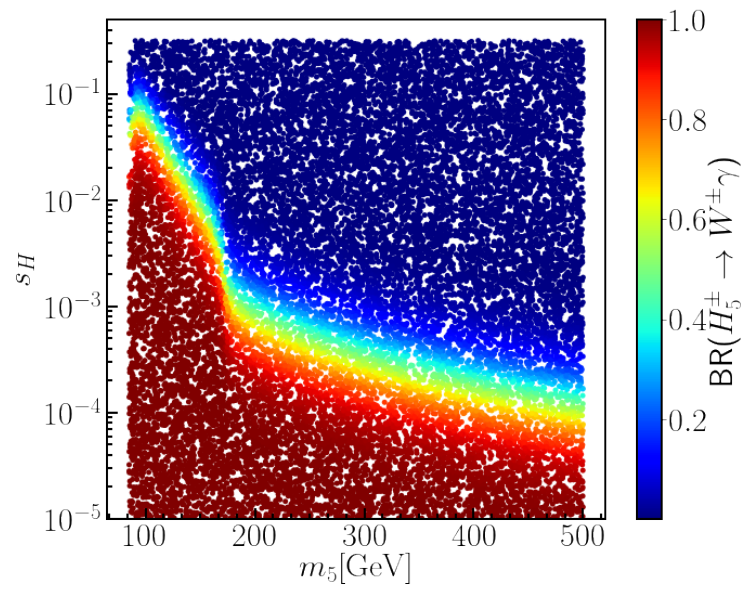
Figure 3 . Dependence of BR( H (cid:6) W (cid:6) (cid:13) ) on m 5 and s H , for M 2 = 40 GeV. Larger values of 5 ! M 2 would move the transition to large BR( H (cid:6) W (cid:6) (cid:13) ) upwards to higher s H values, and smaller 5 ! values of M 2 would move this transition to lower s H